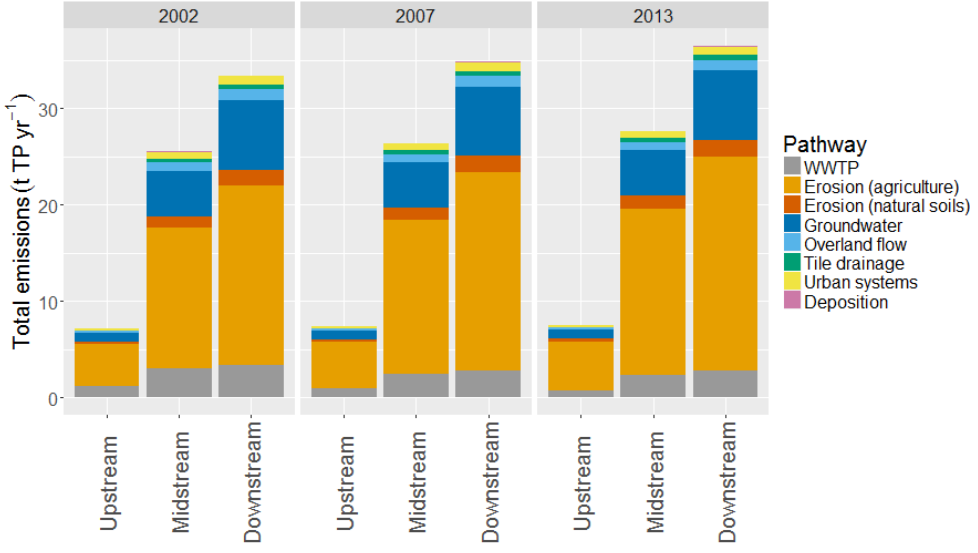
Figure 7. Total TP emissions and share of different pathways in the sub-catchments of the river Pram modelled with MONERIS for the years 2002, 2007 and